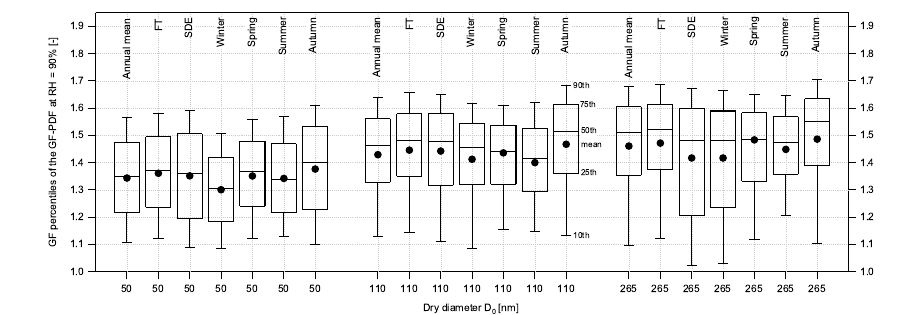
Fig. 4. 10th, 25th, 50th, 75th, and 90th percentile of the GF-PDF for D 0 =50, 110, and 265nm for the complete 13-month data set, for strong Saharan dust events, for free troposphere conditions (2a.m.–8a.m. UTC=CET-1h) and as well as for the seasons winter, spring, summer, and